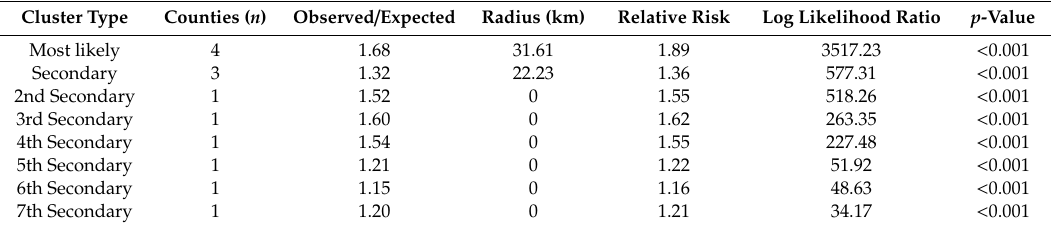
Table 3. Results for spatial clusters of varicella in Chongqing from 2014 to 2018.